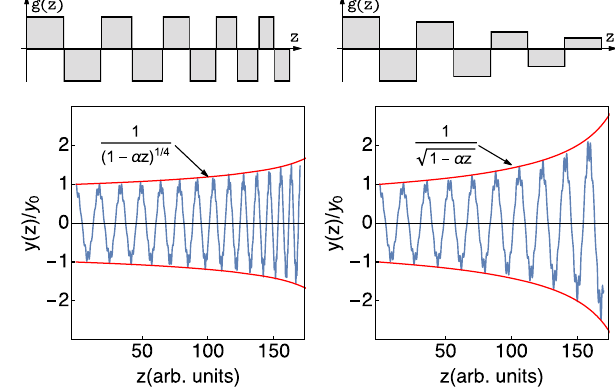
FIG. 2. Solution of Eq. (1) for s ¼ 0 , loss parameter α ¼ 0 . 005 ffiffiffiffi p K L ¼ 0 . 35 π (phase advance 0 . 2266 π ) for adap- and maximum tive beam focusing using lens length variation L ∝ (left panel) and lens magnetic gradient variation g 0 ∝ ð 1 − α z Þ (right